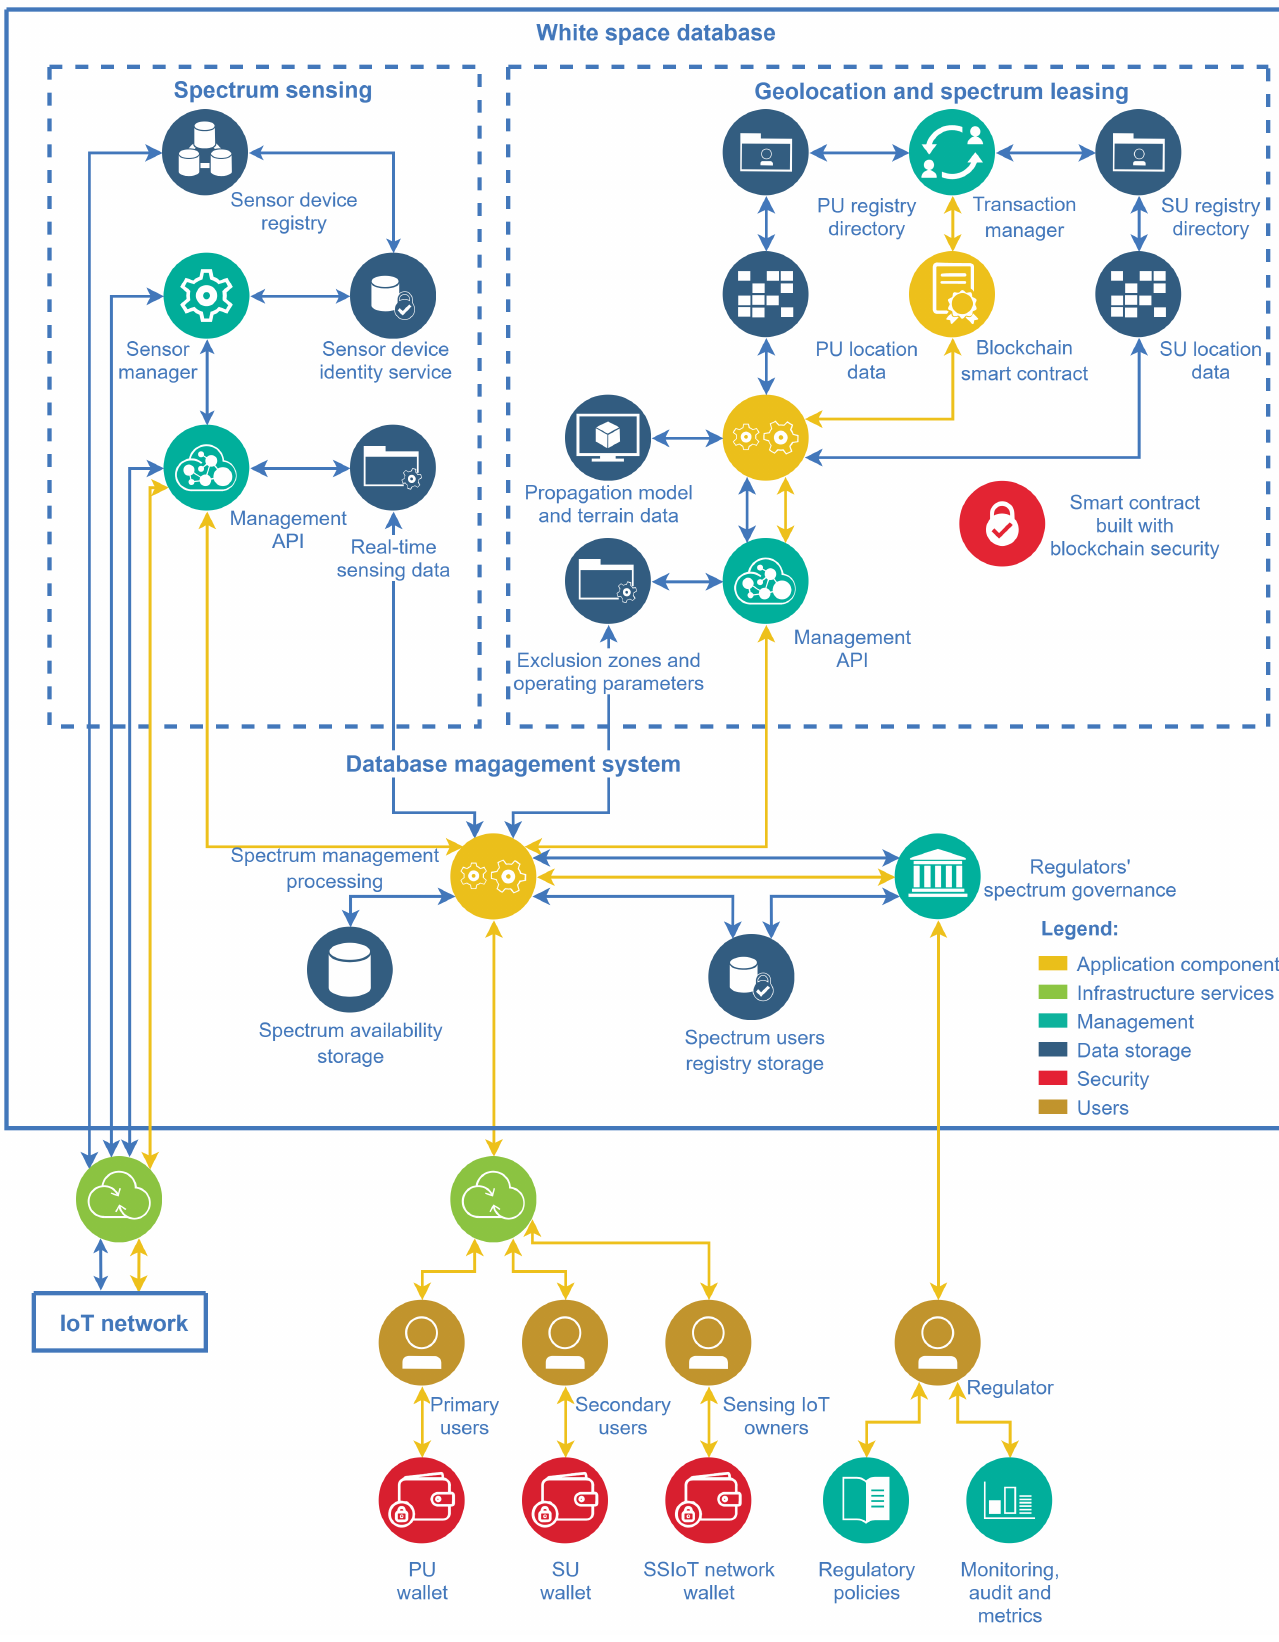
Figure 8. WSDB architecture with entities relationships for subsystems integration and user